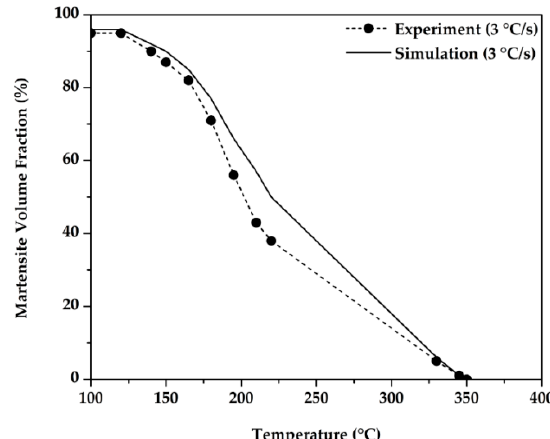
Figure 16. Comparison between the calculated bainite volume fraction and measured data on the forged block: Martensite volume fraction at 3 °C/s.